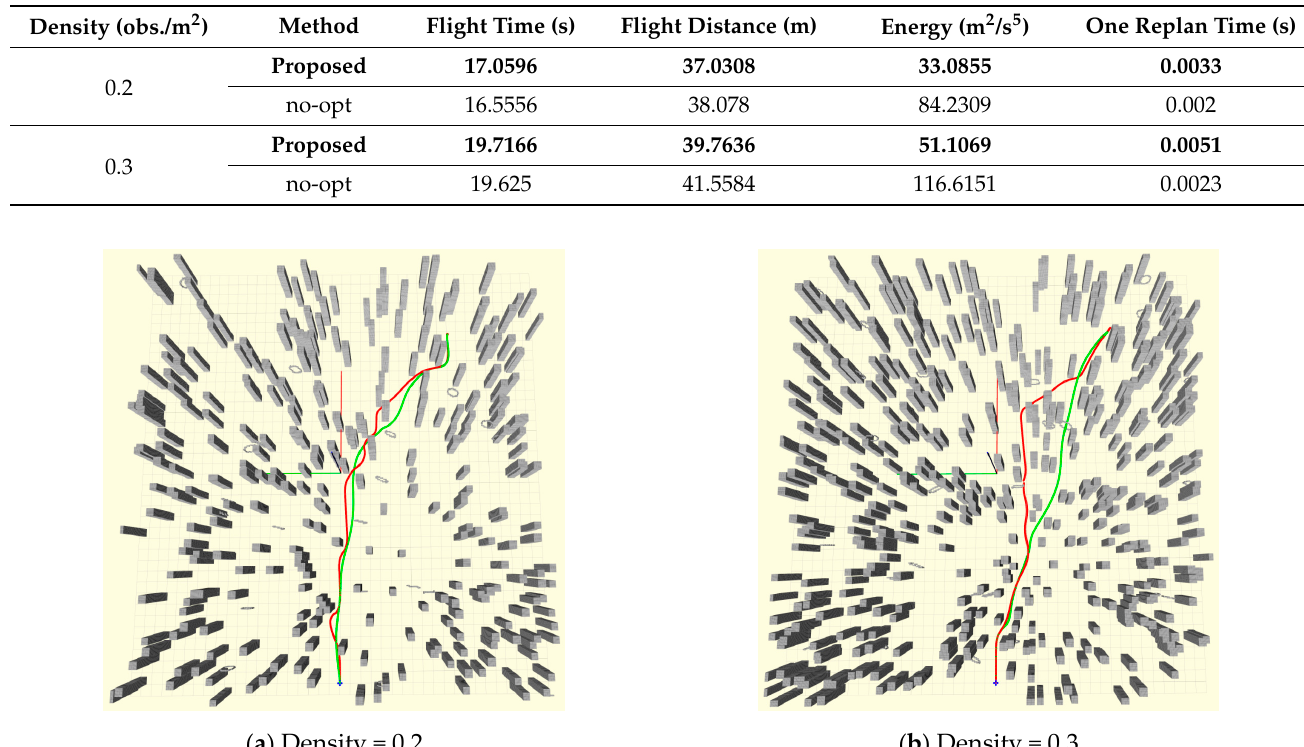
Figure 13. Samples of the trajectories generated by the proposed method (green) and no-opt (red) in different densities.